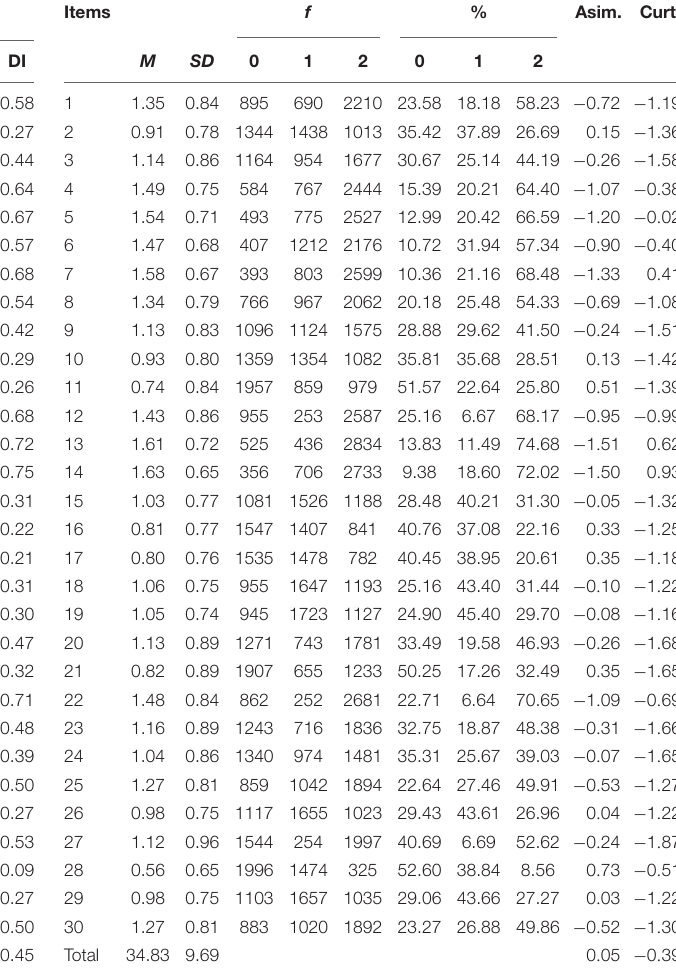
TABLE 4 | Descriptive statistics of the items of the BECOMA